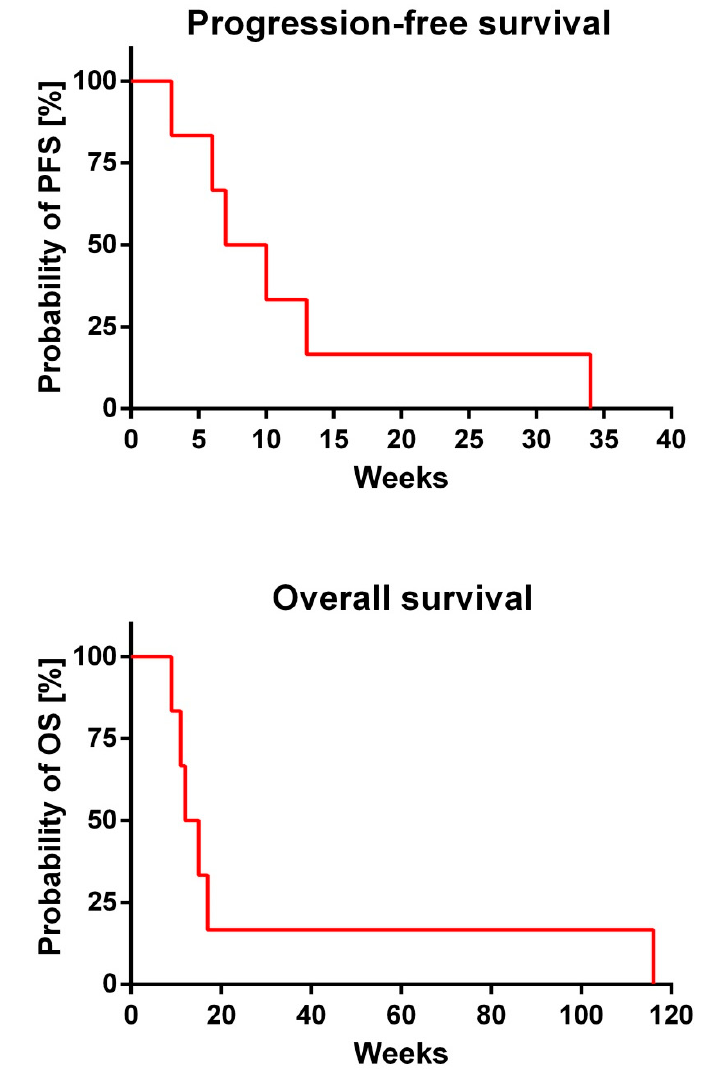
Figure 3. Progression-free survival (PFS) and overall survival (OS) after shunt implantation.